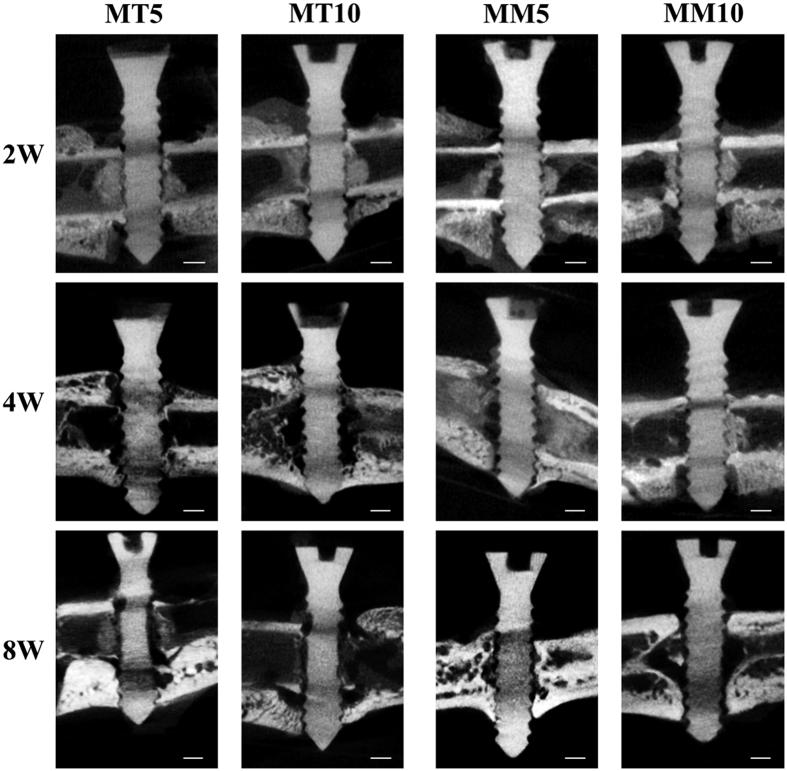
CT image of HP Mg screws in different groups.The bar represents 1 mm.